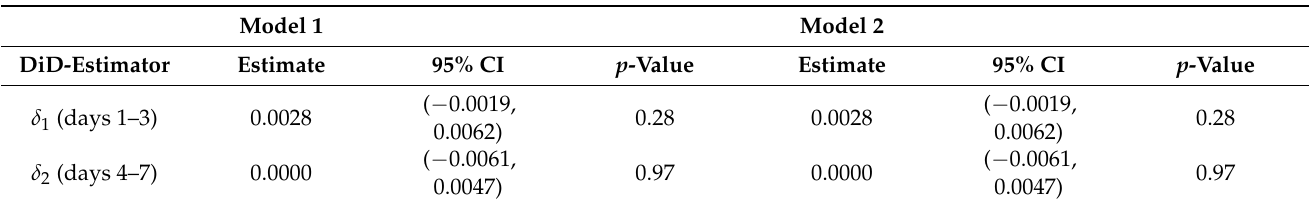
Table 2. Results from regression models estimating the effect of three door-to-door campaigns promoting COVID-19 testing accompanied by mobile testing facilities on COVID-19 testing